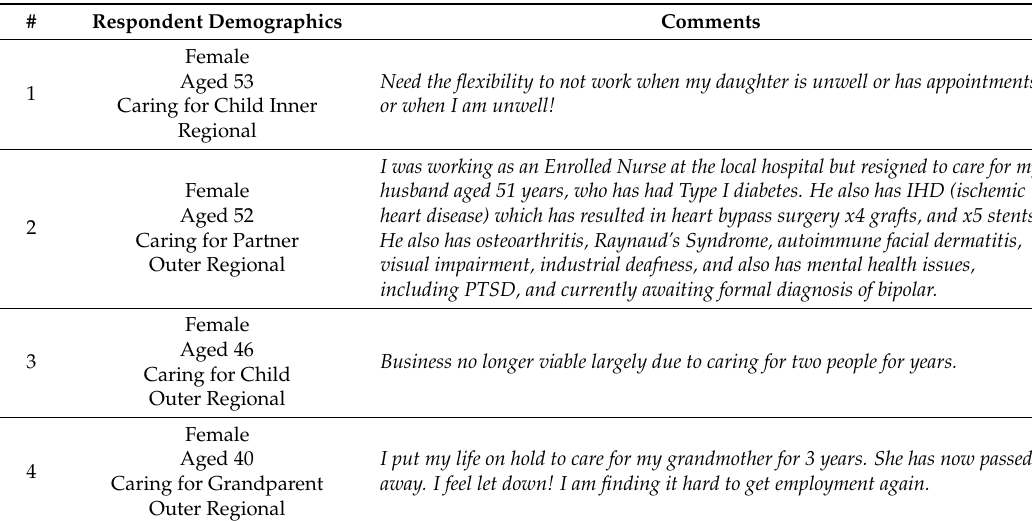
Table 3. Respondent commentary on employment and